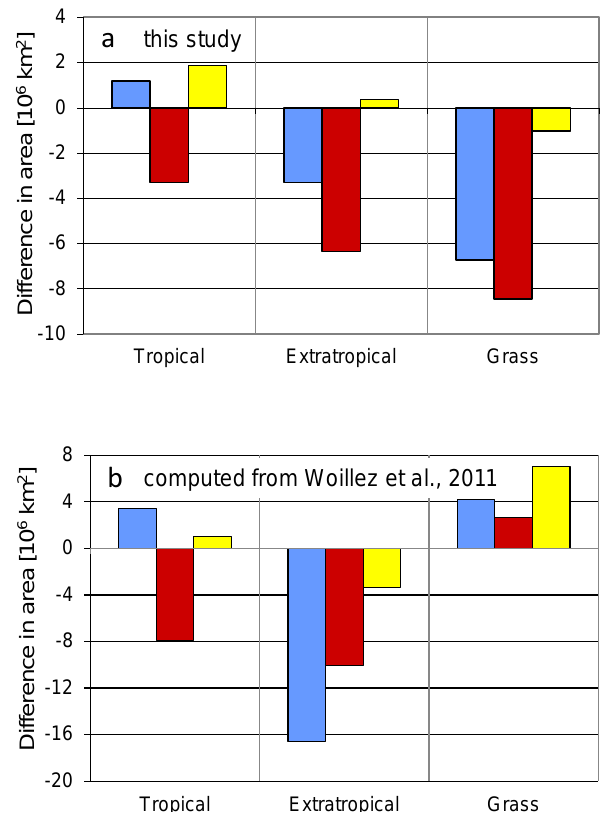
Fig. 9. Same as Fig. 6, except that in the upper part (a) , aggregated PFTs are depicted. Tropical: tropical woody PFT = tropical ever- green and deciduous trees and raingreen shrubs; Extratropical: ex- tratropical woody PFT = evergreen and deciduous trees and decid- uous shrubs; Grass: C3 and C4 grass. In the lower part (b) , fac- tors and synergies are shown for the global foliage coverage (in 10 6 km 2 ) for tropical tree, combined temperate and boreal trees and grass computed from the study by Woillez et al.